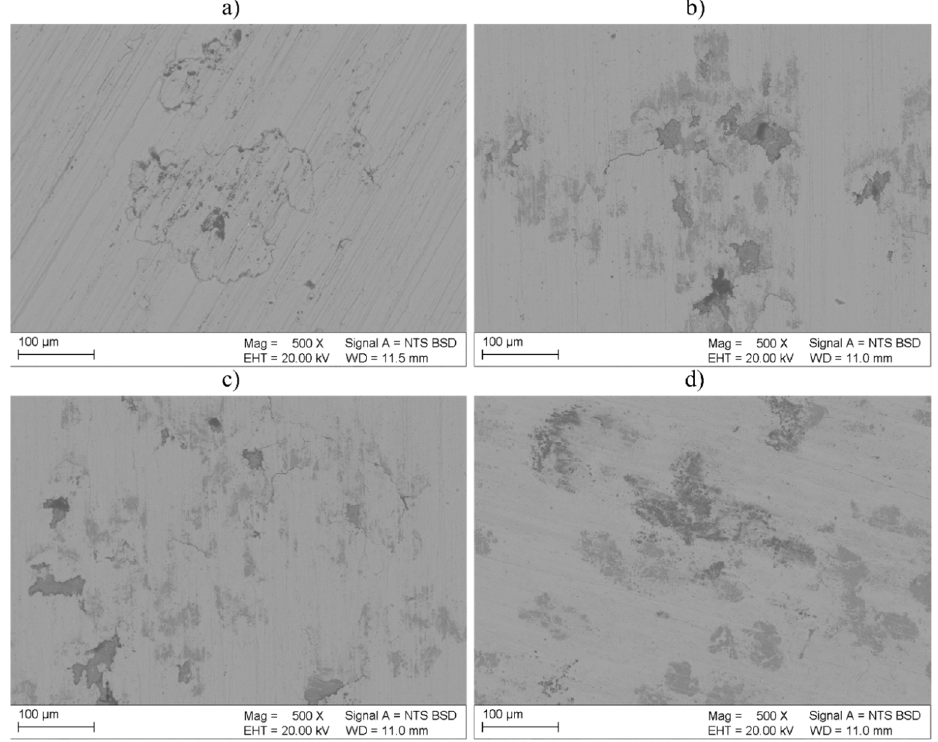
Figure 12. Morphologies of corrosion damage after potentiodynamic polarization tests, SEM, coatings: ( a ) M1, ( b ) C1, ( c ) C3 and ( d ) C5 designations in accordance with Table 3.